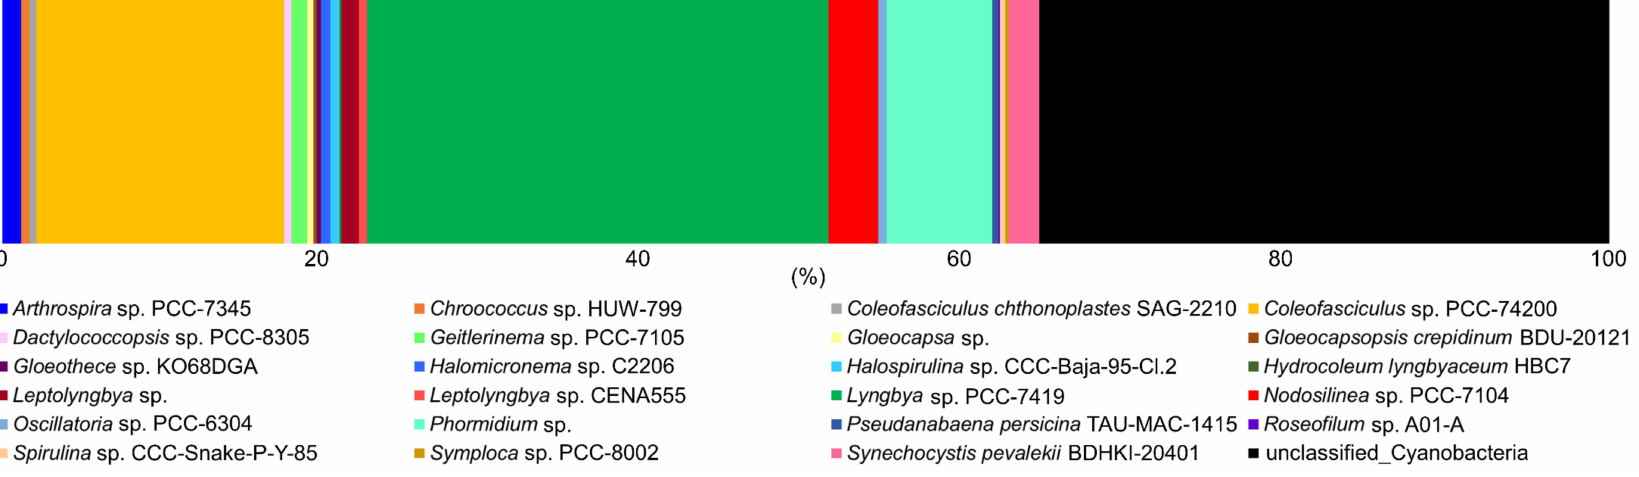
Figure 5. Bar plot showing the relative abundance (%) of amplified sequences of total cyanobacterial species in mid and upper Laguna Madre. Abundances were normalized to the total number of